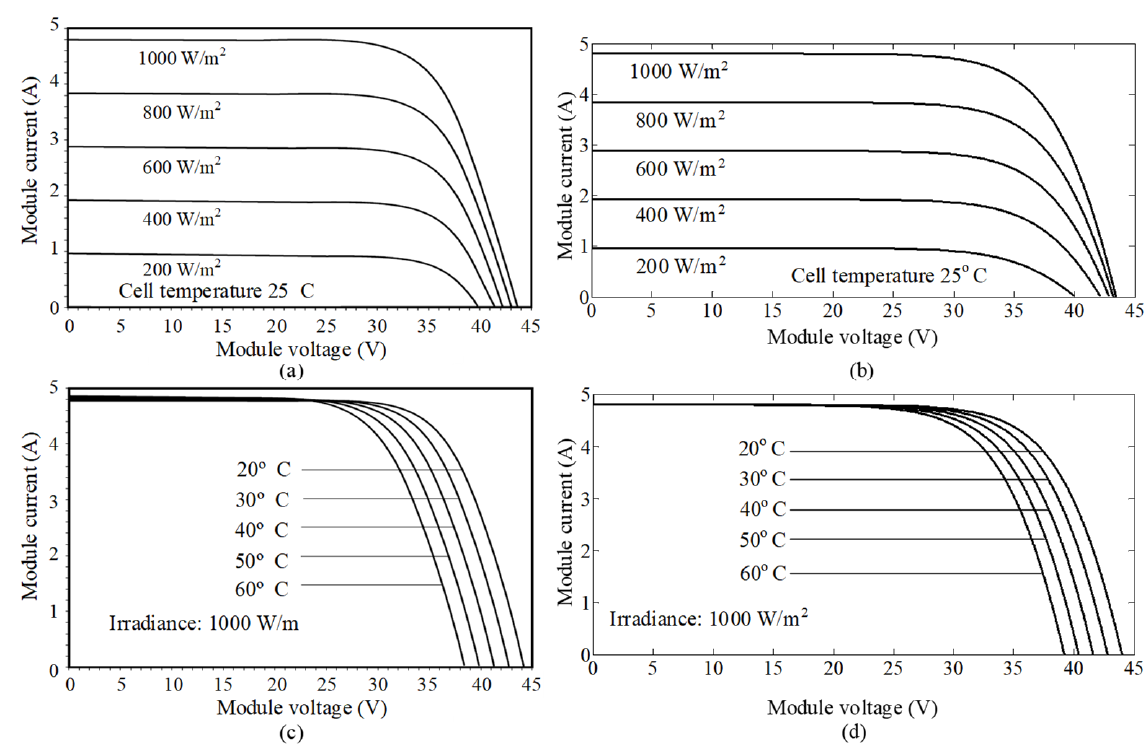
Figure 3. Current and voltage (I–V) photovoltaic (PV) curves. ( a ) I–V characteristics provided by the manufacturer for different irradiance values; ( b ) I–V characteristics simulated for different irradiance values; ( c ) I–V characteristics provided by the manufacturer for different temperatures and ( d ) I–V characteristics simulated for different temperatures.